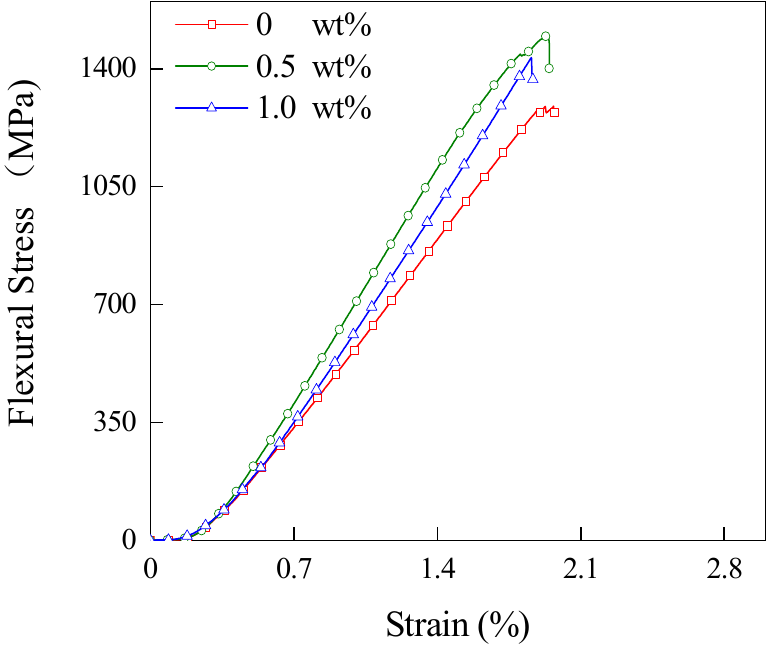
Figure 4. The flexural stress–strain curves of the composites with different CNT contents.